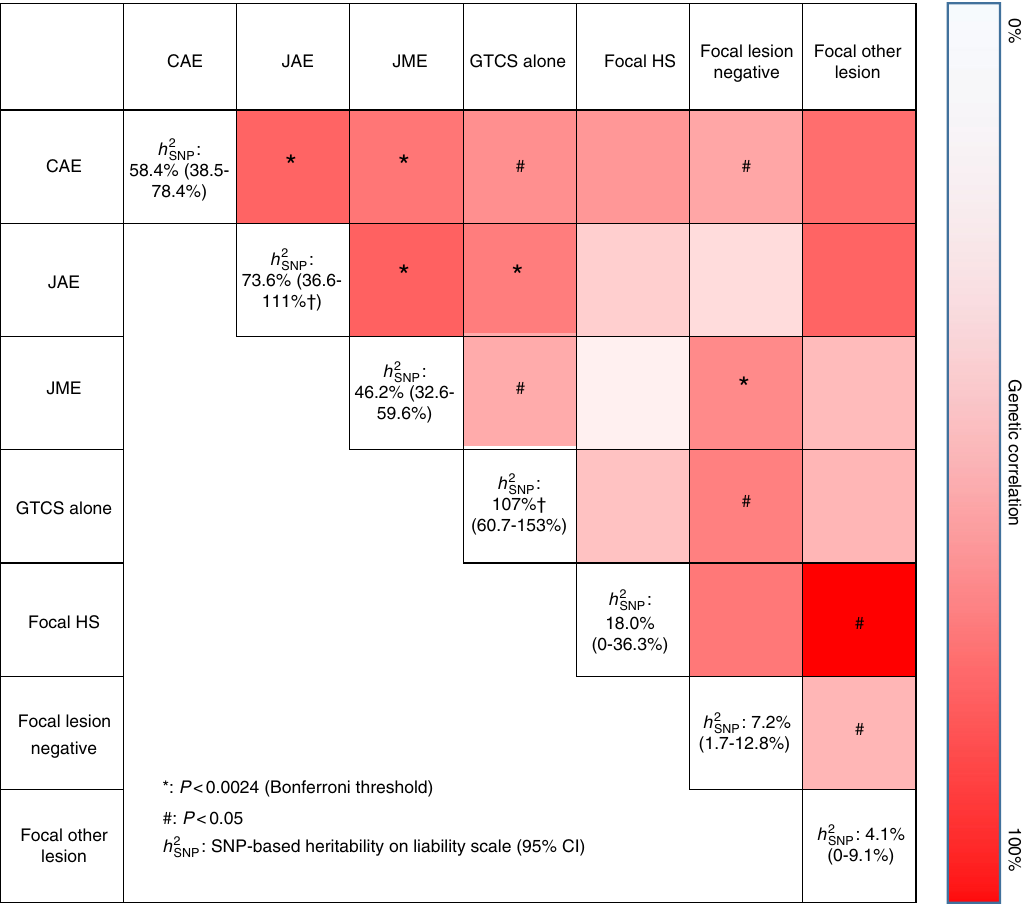
Fig. 4 Heritability estimates and genetic correlations between epilepsy syndromes, calculated using LDAK. Subjects with a diagnosis of both CAE and JAE were excluded from both phenotypes. The genetic correlation coef fi cient was calculated with LDAK and is denoted with a color scale ranging from 0% (white) to 100% (red). # P < 0.05; * P < 0.0024 (Bonferroni threshold); h 2 L 2 SNP-based heritability on liability scale (95% CI); † heritability estimate exceeded 100%, possibly due to small sample size and large SD; CAE - childhood absence epilepsy, JAE - juvenile absence epilepsy, JME - juvenile myoclonic epilepsy, GTCS alone - generalized tonic-clonic seizures alone, focal HS - focal epilepsy with hippocampal sclerosis